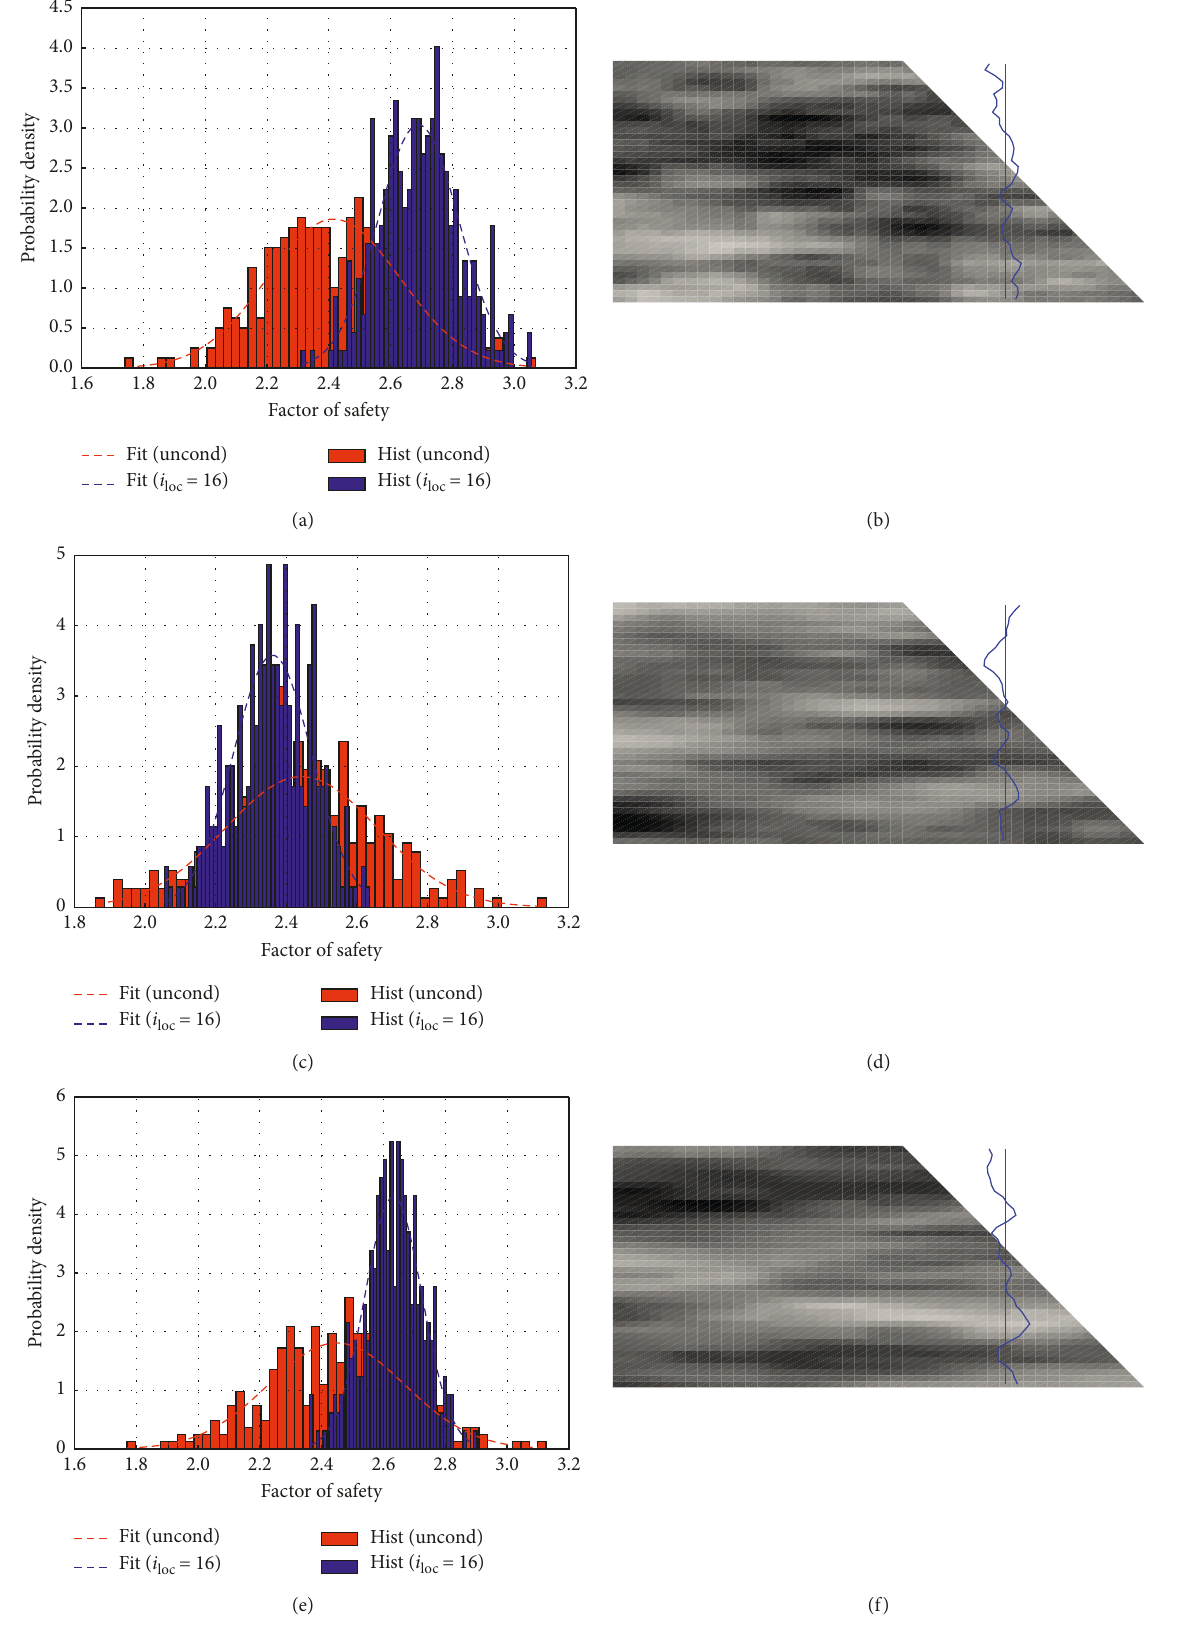
Figure 7: Simulation results in the first phase of example 1 (based on θ � 1.0m and 300 realisations per Monte Carlo simulation, CPT location v � 6m; (c–d) θ � 10m; (e–f) θ � 14m. (a) PDF of realised factor of safety. (b) Example realisation and CPT. (c) PDF of fixed at i � 16): (a–b) θ h h h realised factor of safety. (d) Example realisation and CPT. (e) PDF of realised factor of safety. (f) Example realisation and